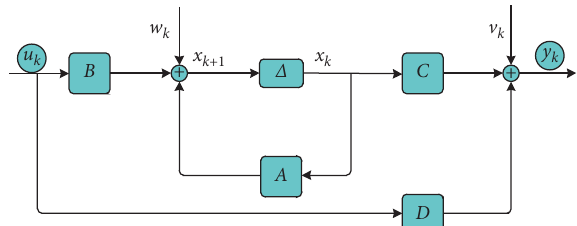
Figure 1: Flowchart of the combined deterministic-stochastic